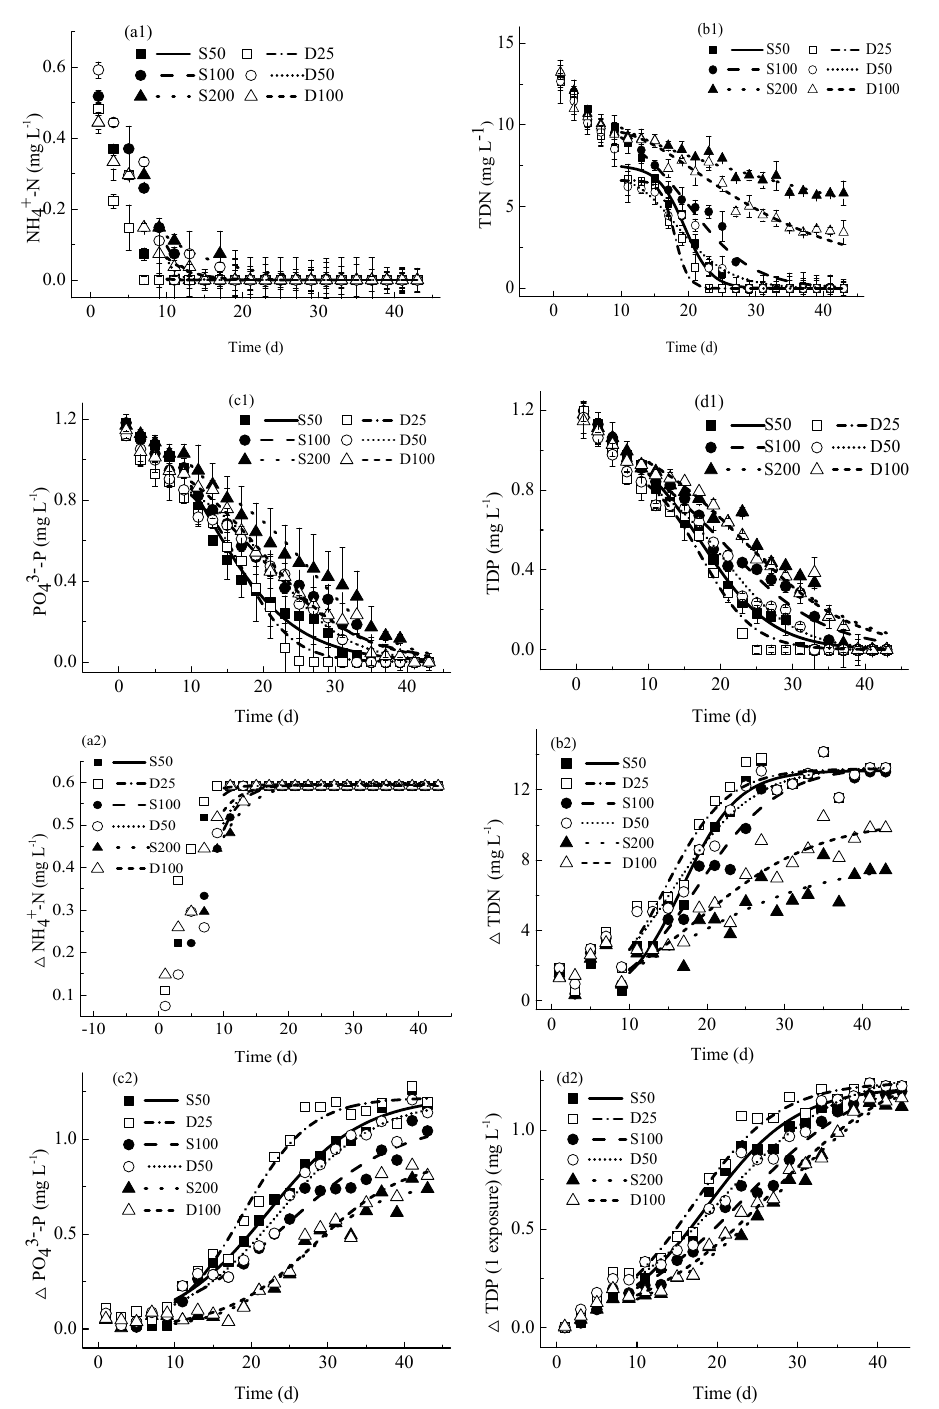
Figure 2. Variations of concentrations of nutrients ( a1 – d1 ) and concentrations of consumed nutri- ents ( a2 – d2 ) with time. Dots–measured values, lines–fitted values. ( a2 – d2 ) with time. Dots–measured values, lines–fitted